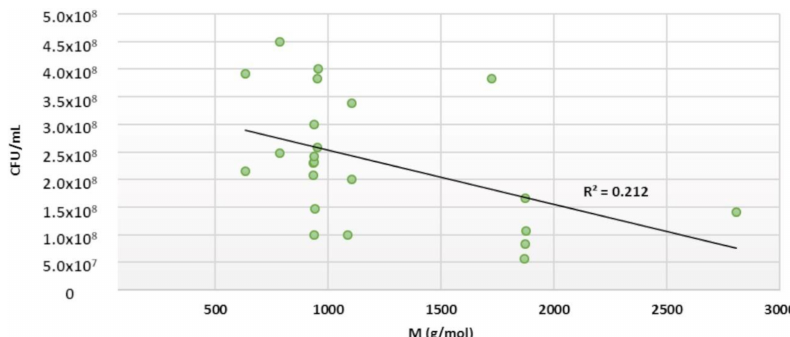
Figure 7. The e ff ect of ellagitannin molecular size on its antimicrobial strength against C. perfringens (24 h treatment with 0.5 mM tannin solution). A linear regression model was used.